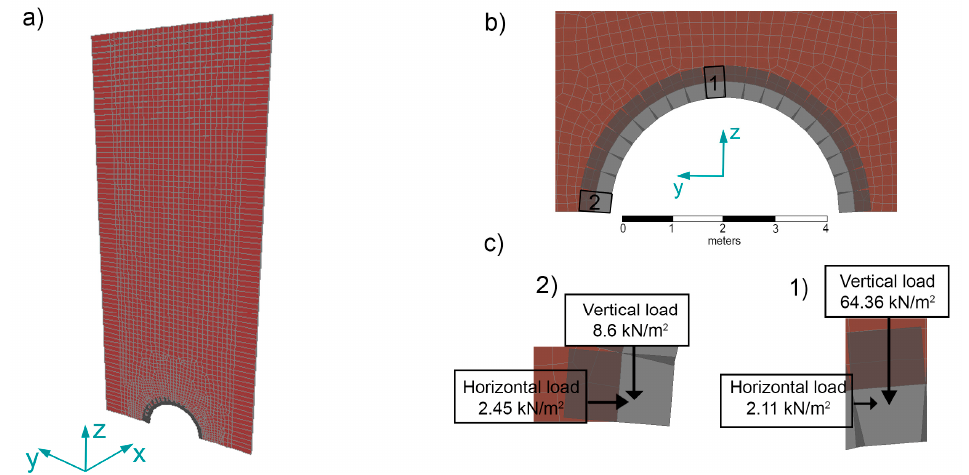
Figure 5. ( a ) Ground-vault model; ( b ) ground-vault mesh detail; ( c ) vertical and